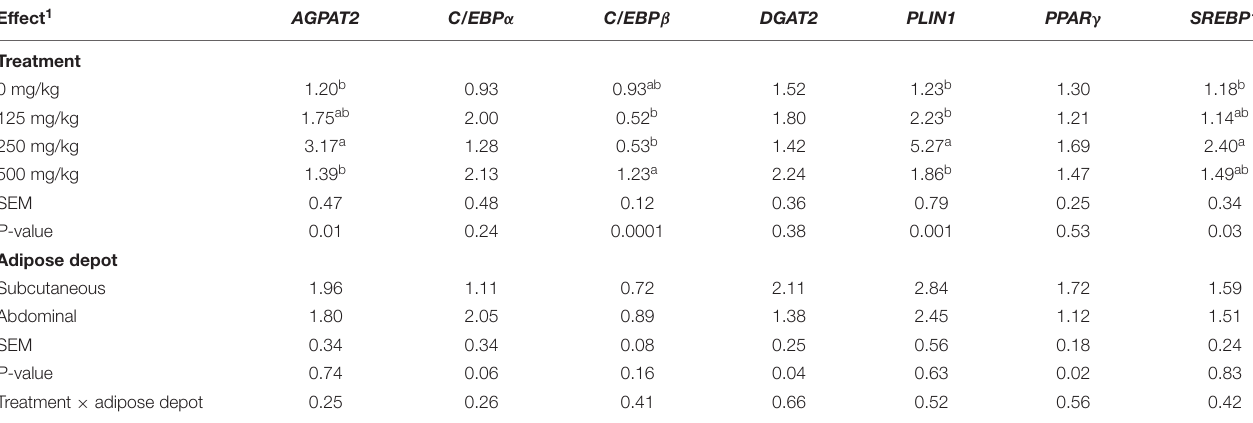
1 Values represent least squares means and pooled standard errors of the means with associated P-values for the effect of dietary treatment, adipose tissue depot, and their interaction (n = 10). Different superscripts within an effect for each gene are significantly different at P < 0.05, Tukey’s test. AGPAT2, 1-acylglycerol-3-phosphate-O-acyltransferase 2; C/EBP α , CCAAT/enhancer-binding protein alpha; C/EBP β , CCAAT/enhancer-binding protein beta; DGAT2, diacylglycerol acyltransferase; PLIN1, perilipin-1; PPAR γ , peroxisome proliferator-activated receptor gamma; SREBP1, sterol regulatory element-binding transcription factor